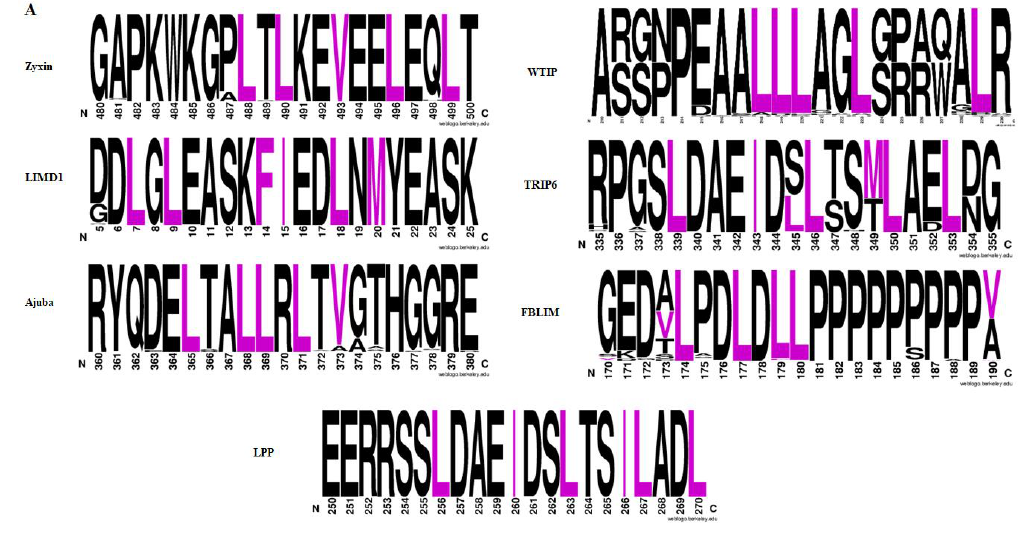
Figure 2. ( A ) The nuclear export sequences (NES) of Zyxin family proteins. To investigate the con- 145 servation of NES in proteins from other organisms, we aligned the human protein sequence using 146 BLAST against the non-redundant protein sequence database. The resultant sequences obtained 147 from BLAST were subjected to multiple sequence alignment, presented using WEBLOGO ( B ) The 148 NES sequence for each protein was identified through the NetNES webserver, and the sequences 149 were aligned using MultAlin. ( C ) WEBLOGO was used to investigate the conservation of residues 150 in the sequences, which suggested the presence of signature LxxLxL/LxxxLxL, (L = L/V/I/F/M; x = 151 any amino acid) repeat, in NES sequence across all the members of Zyxin family except zyxin and 152 LPP which showed LxxxLxxL/LxxLxxL consensus sequence. ( D ) The nuclear localization sequence 153 (NLS) for the Zyxin family members was fetched by the NLStradamus webserver with a prediction 154 cut-off set at a recommended value of 0.6. The conservation of predicted sequences was analysed 155 using